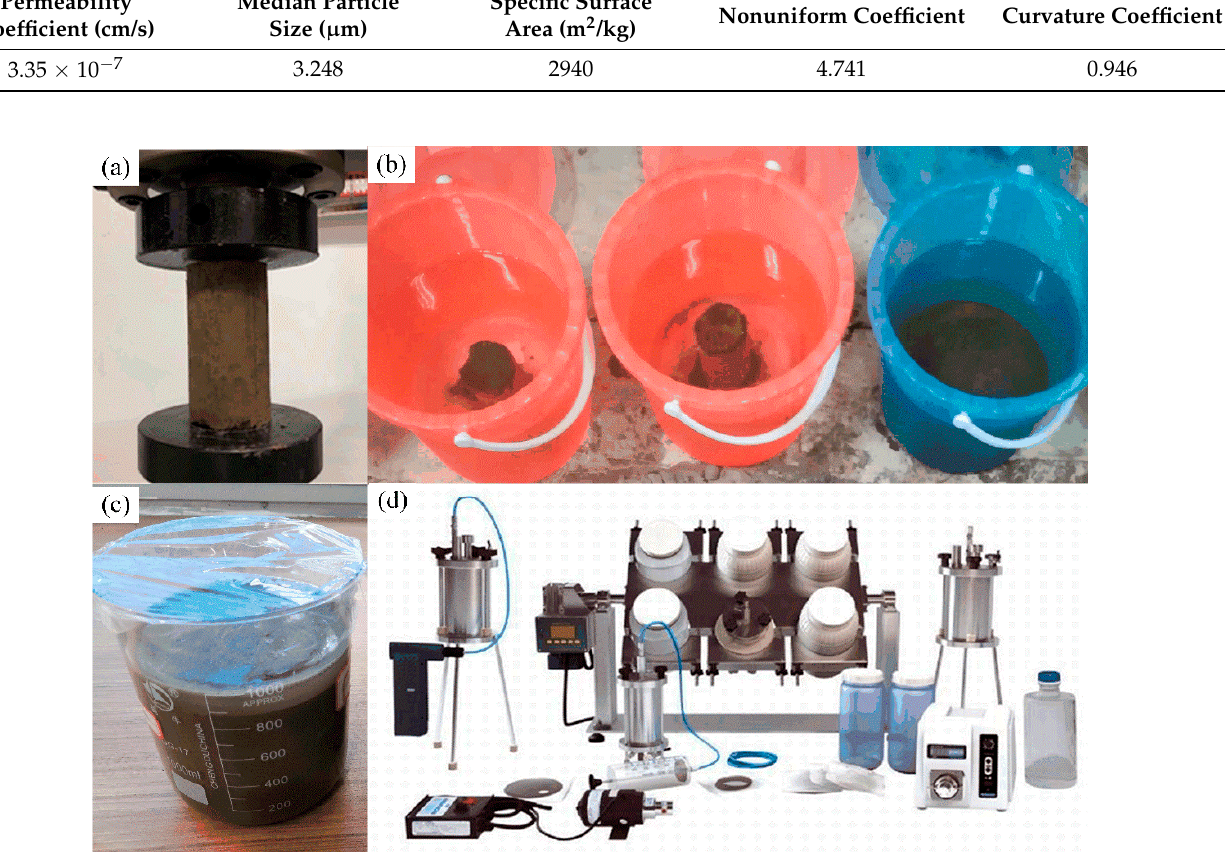
Figure 2. Contamination analysis experiments of RCB: ( a ) uniaxial compressive strength test; ( b ) immersion tests; ( c ) bleeding test; ( d ) leaching toxicity test. Table 2. Results of bleeding and immersion tests (unit: mg/L).